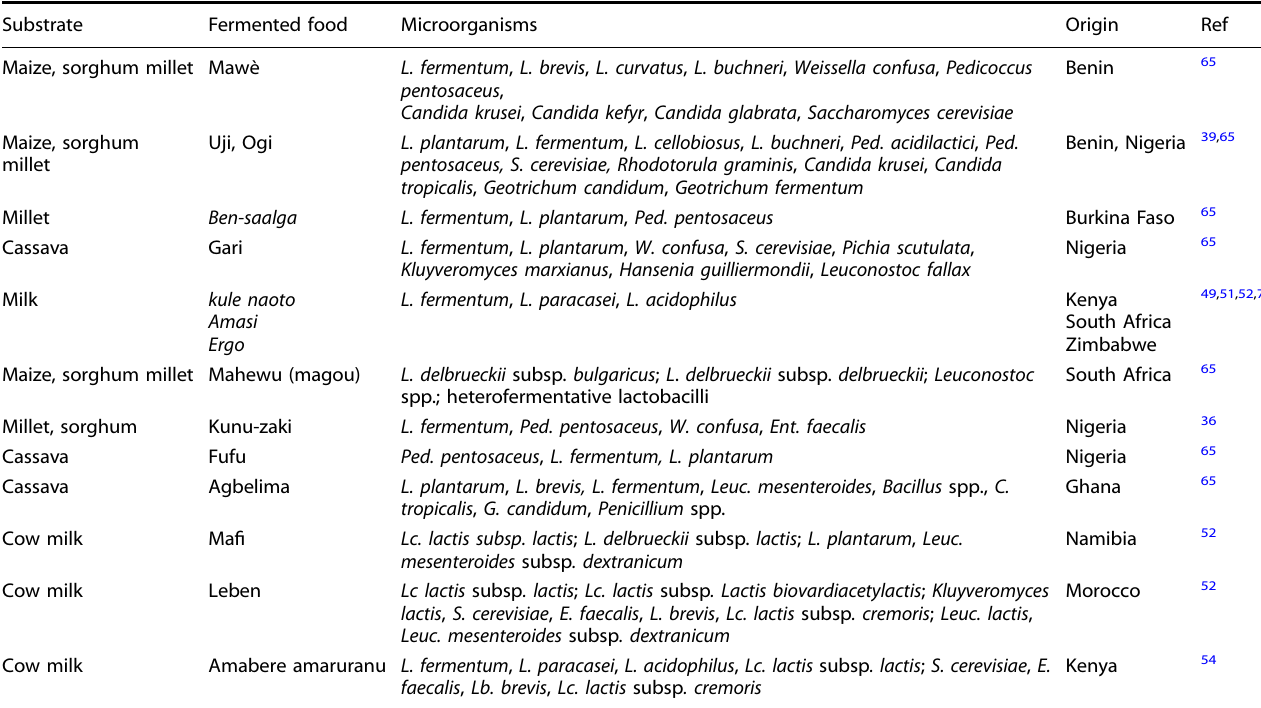
Table 1. Occurrence of various fermenting microorganisms among commonly consumed selected African fermented